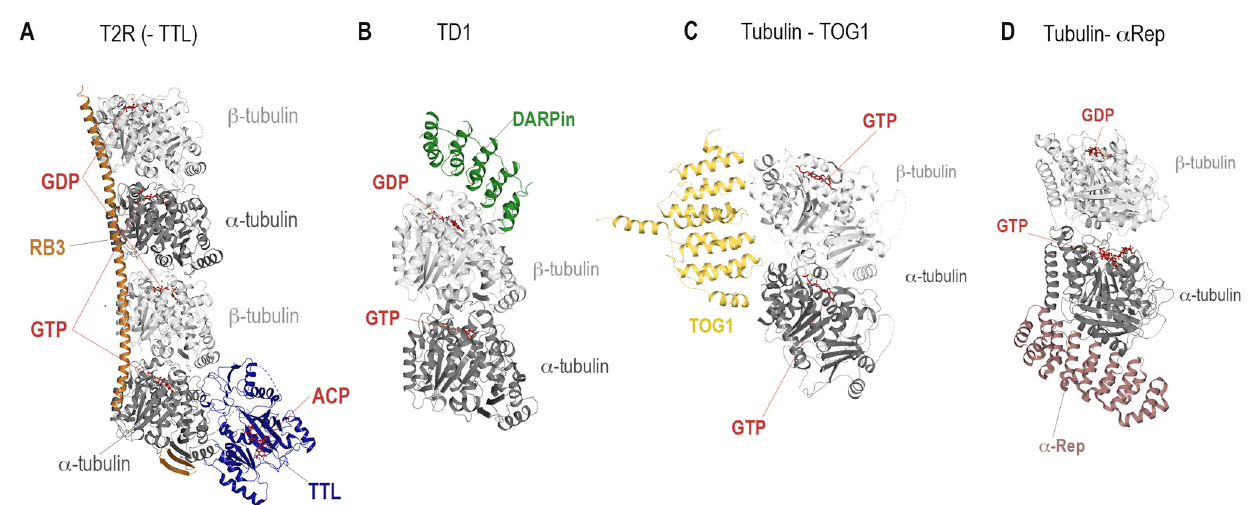
Figure 3. The crystallization systems ( A ) T 2 R(-TTL) (PDIB ID: 4I55, [44]), ( B ) TD1 (PDB ID 4DRX, [45], ( C ) Tubulin-TOG1 (PDB ID: 4FFB, [47]) and ( D ) Tubulin- α Rep (PDB ID: 6GWC, [37]) are depicted. The proteins are shown in ribbon representation, α - and β -tubulin are colored dark and light grey, respectively. The SLD/RB3 protein is colored orange, the TTL in blue, DARPin in green, TOG1 in yellow and alpha-Rep in brownish color. Nucleotides are shown in sticks representation and colored red. The structure of the SLD tubulin complex, T 2 R crystallization system corresponds to the T 2 R-TTL structure without the bound TTL and thus was not shown separately.